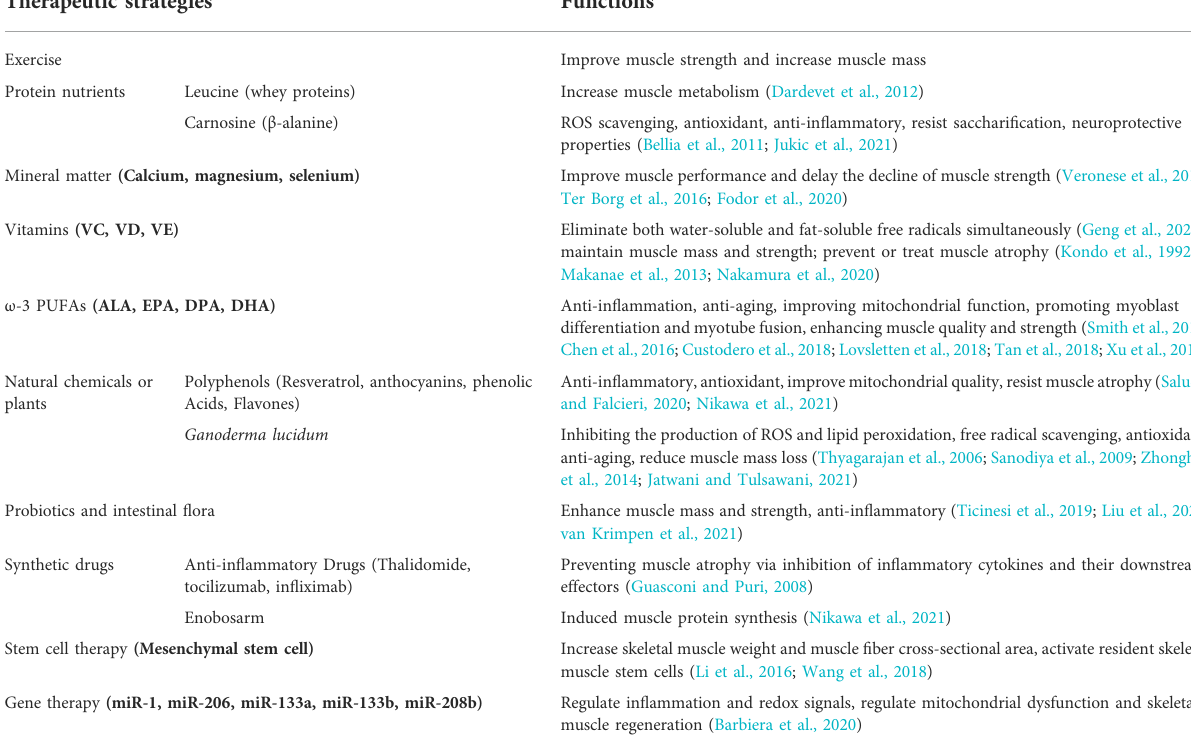
TABLE 1 The functions of potential therapeutic strategies for sarcopenia during aging. Therapeutic strategies